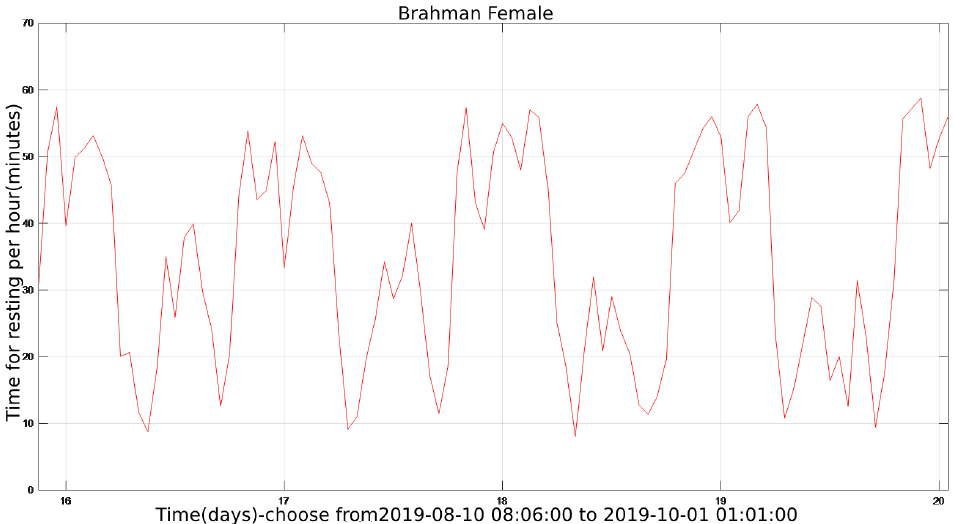
Figure 4. The enlarge vision shown 4